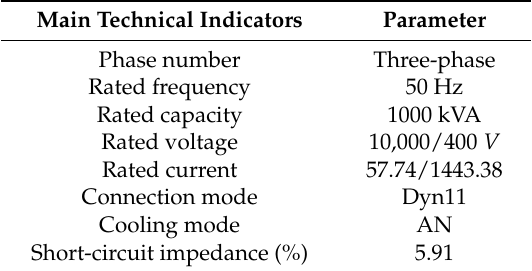
Table 1. Main technical parameters of the SCB10-1000/10 dry-type transformer.